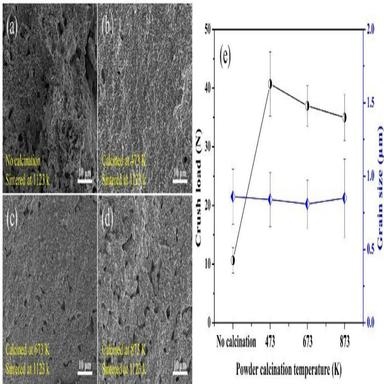
SEM fracture morphology of the pebbles sintered at 1123 K in air using powders calcined at different temperatures: (a) without calcination, (b) 473 K, (c) 673 K, (d) 873 K; (e) crush load and grain size.